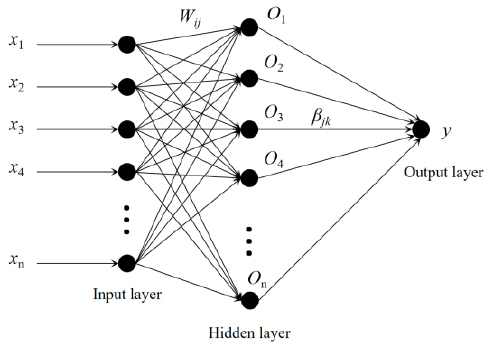
Figure 2. Topological structure of extreme learning machine.